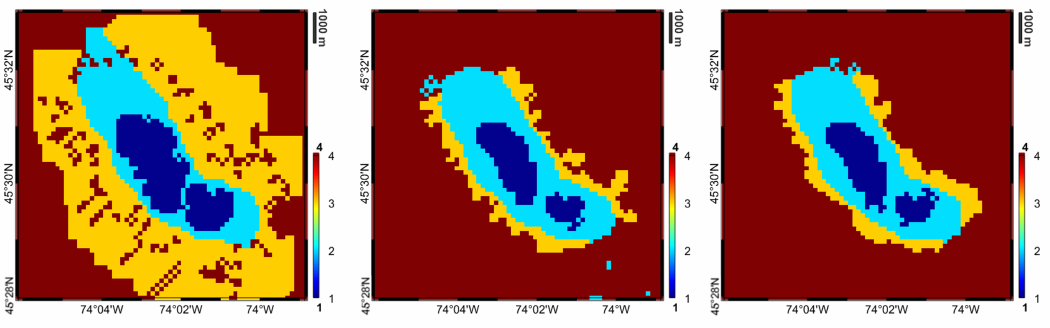
Figure 10. Estimated labels at 1.5 km from gravity-only inversion ( left ), magnetic-only inversion ( centre ) and joint inversion ( right